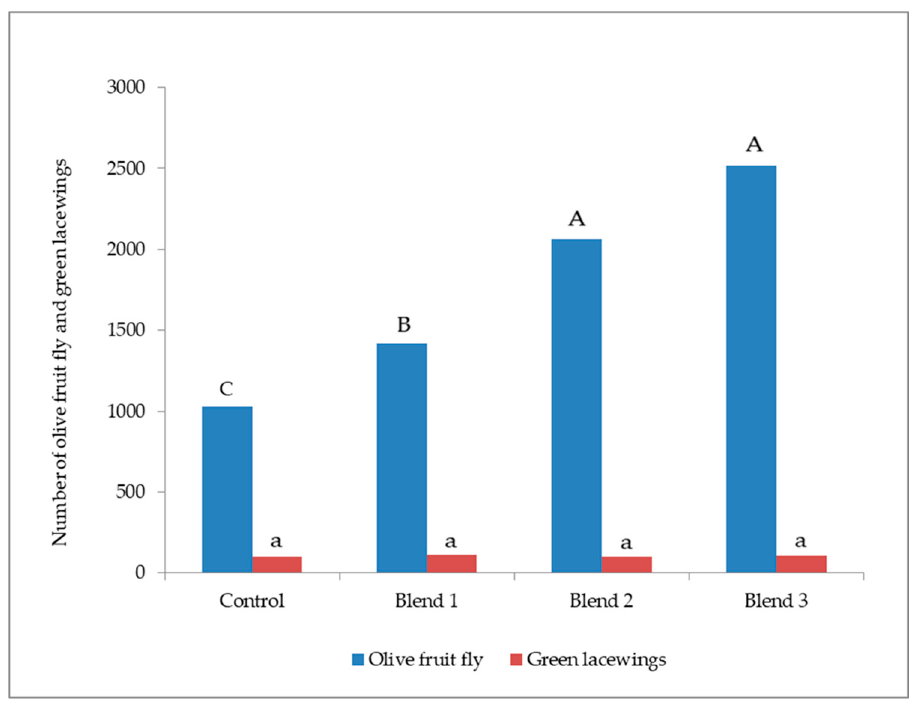
Figure 1. Total number of Bactrocera oleae and green lacewings captured on yellow sticky (YS) traps containing three blends of olive fruit fly-associated yeast volatile compounds in an olive orchard. Blends of volatile compounds were: (Blend 1) 1:1 isoamyl alcohol and 2-phenethyl alcohol; (Blend 2) 1:1:1 isoamyl alcohol, 2-phenethyl alcohol and 2-phenethyl acetate; (Blend 3) 1:1:1 isoamyl alcohol, 2-phenethyl acetate and isobutyl acetate; and (Control) control traps containing only hexane. Bars labeled with different uppercase letter indicate significant differences between tested YS traps for olive fruit fly, while bars labeled with different lowercase letters indicate significant differences between tested YS traps for green lacewings; (LSD test at p ≤